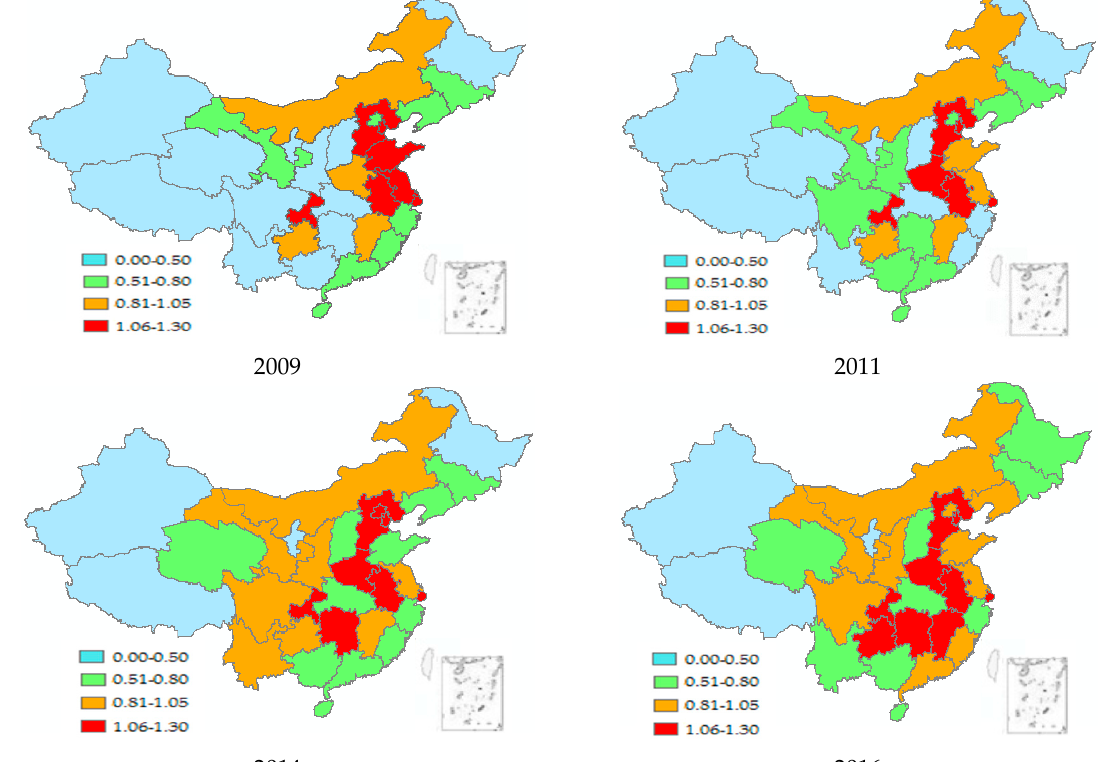
Figure 3. Comparison of spatial and temporal changes in ITE .